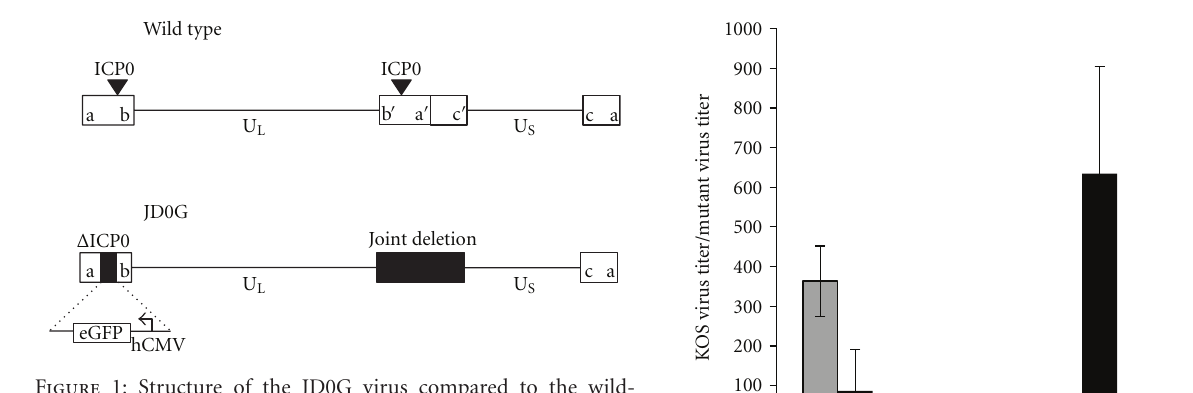
Figure 1: Structure of the JD0G virus compared to the wild- type HSV-1 virus. Schematics depicting the genome structure of wild-type HSV-1 (top) and the JD0G virus (bottom). The unique long (U L ) and unique short (U S ) portions of the viral genome are indicated with solid lines, and the repeat regions of the genome (ab/b (cid:3) a (cid:3) , a (cid:3) c (cid:3) /ca) are shown as open boxes. The locations of the two ICP0 loci are designated with inverted triangles. Black boxes represent deleted regions of the JD0G genome. The joint deletion removes a region spanning positions from 116,982 to 132,605 of the HSV genome (nucleotide positions based on NC 001806). The terminal ICP0-deletion ( Δ ICP0) replaces the ICP0 coding sequence with an hCMV:eGFP expression cassette.